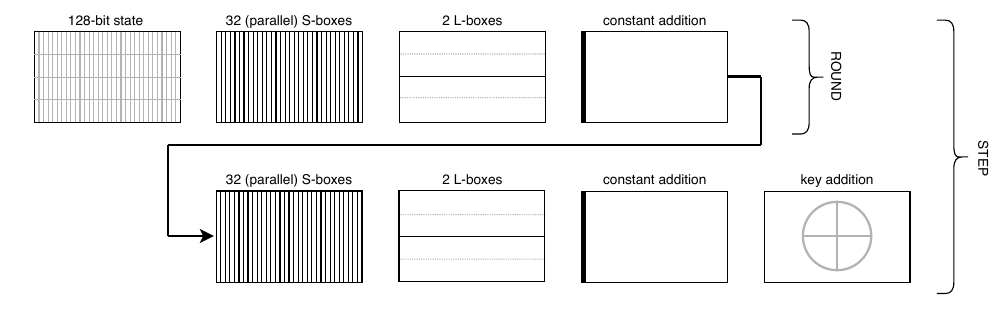
Figure 4: Round and step of Clyde-128 : high-level view.